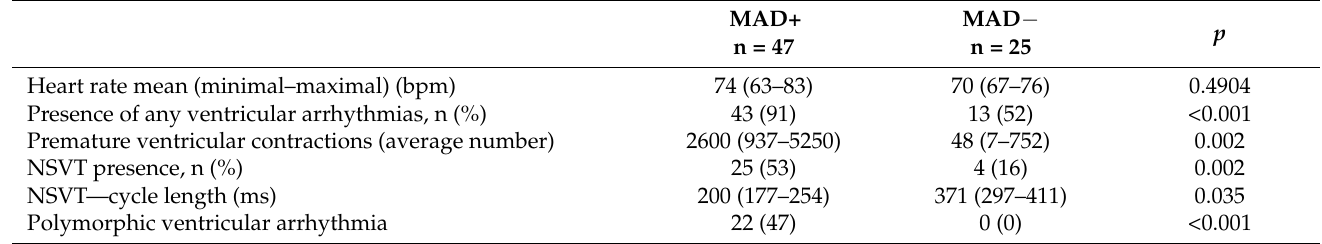
Table 3. The results of HOLTER-ECG monitoring performed within one month after the